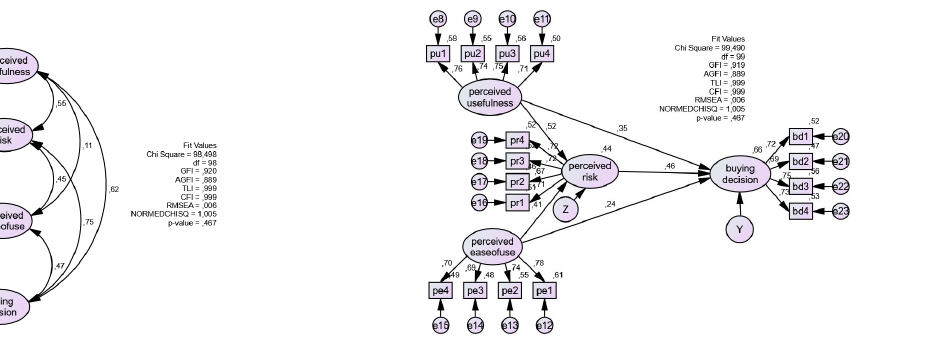
Results of Goodness of Fit (GoF)